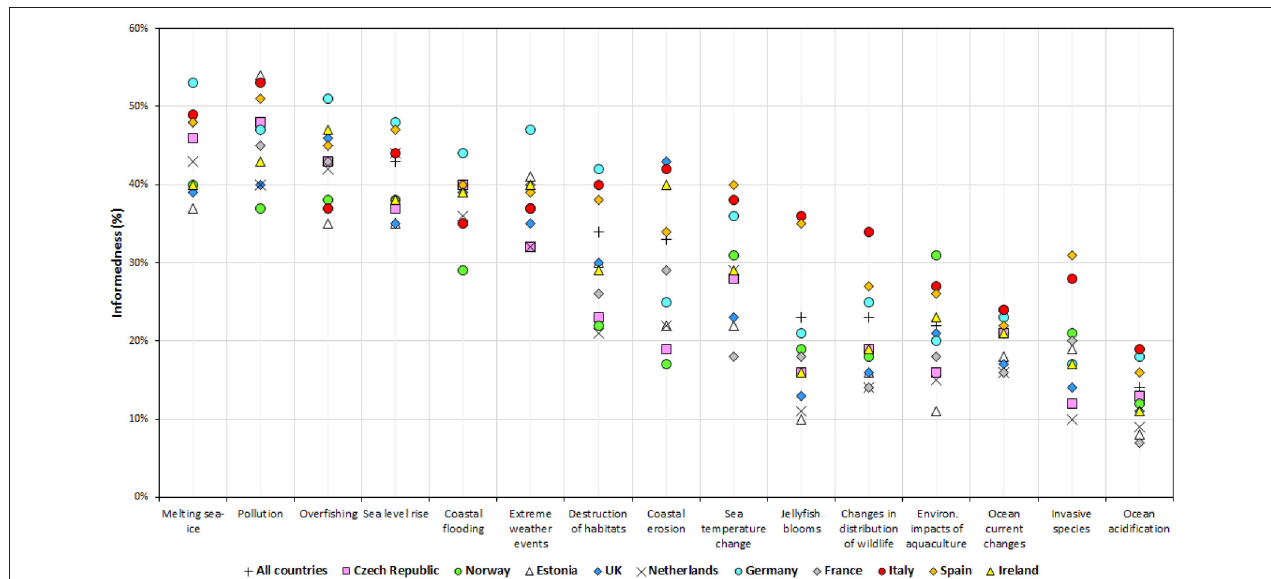
FIGURE 6 | Self-declared level of “informedness” among the 10 European countries surveyed, regarding impacts of marine climate change. The percentage shown represents the “top 2” box scores (on a 5 point likert scale) for “How informed do you feel about each of the following?”